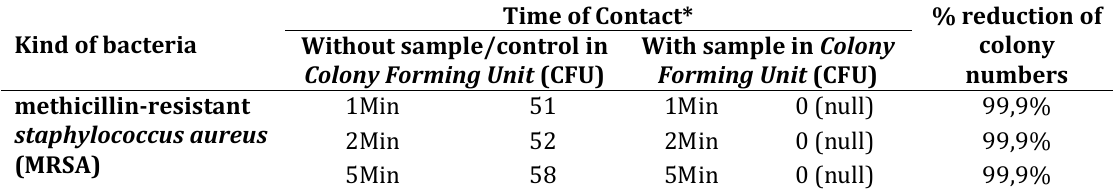
Table V. Percentage of bacterial killing test results on Softaman